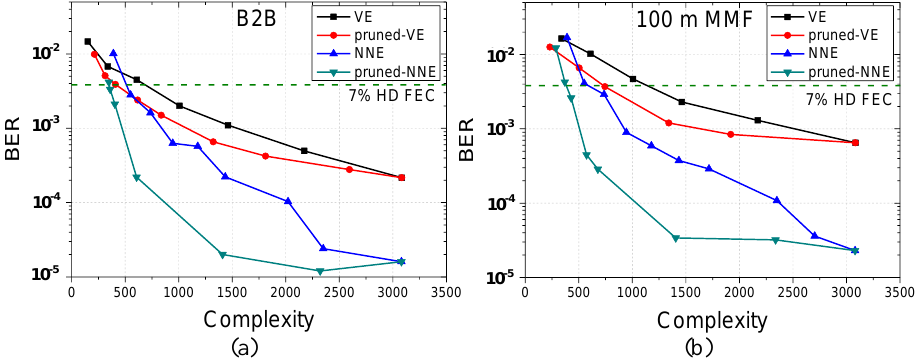
Figure 5. The efficiency comparison for ( a ) B2B case and ( b ) 100 m MMF case at 100 Gbps PAM-4 with pre-distortion.